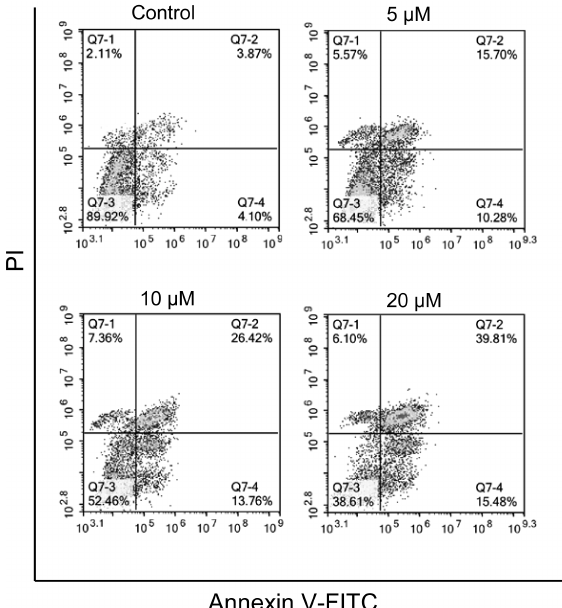
Figure 1. Quantification of apoptosis with annexin V binding to KB-3-1 cells. Cells were incubated in the presence of 3i (5, 10 or 20 µM), or in the presence of DMSO (0.1% v / v ) for 48 h and then Annexin V/PI staining was analyzed by flow cytometry. Etoposide was used as a standard apoptosis inducer to confirm the correct work of the system (data not shown). The results of one of three independent